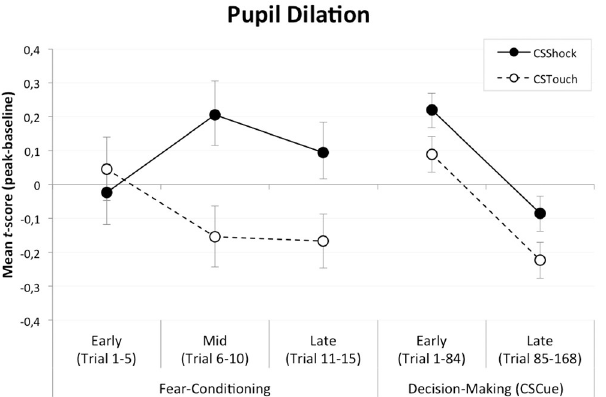
Fig 3. Mean pupil dilation response ( t -score: Peak change from baseline) for the fear-conditioned (CS Shock ) and neutral (CS Touch ) stimulus across fear conditioning (i.e., early, mid, to late acquisition) and CS cue presentation during the decision-making task (i.e., early vs. late). Error bars depict standard error of the mean. Note. CS = Conditioned